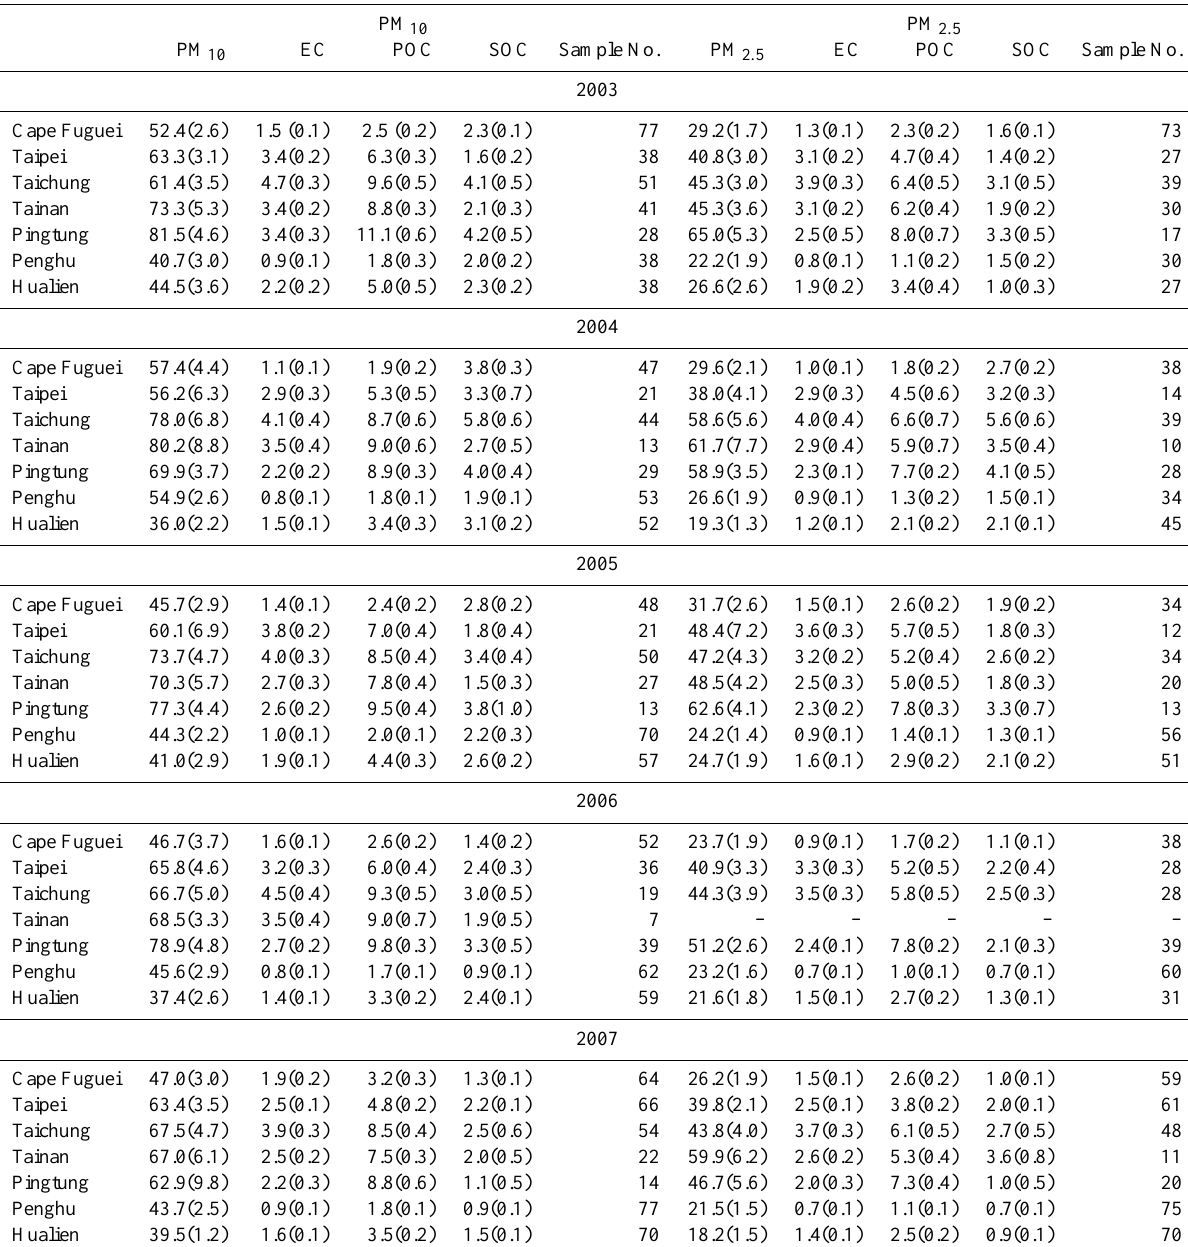
Table 2. Annual means of the PM 10 and PM 2 . 5 and the carbonaceous constituents measured at the respective stations from 2003 to